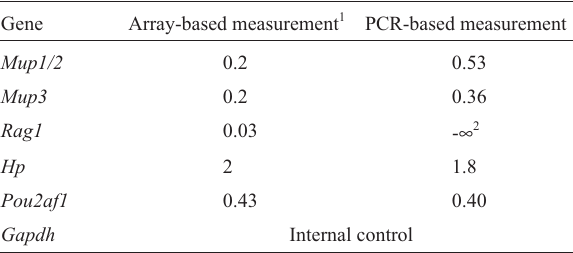
Table 5 - Comparison of some gene expressions in diseased femurs, measured by microarray and semi-quantitative RT-PCR. Gene